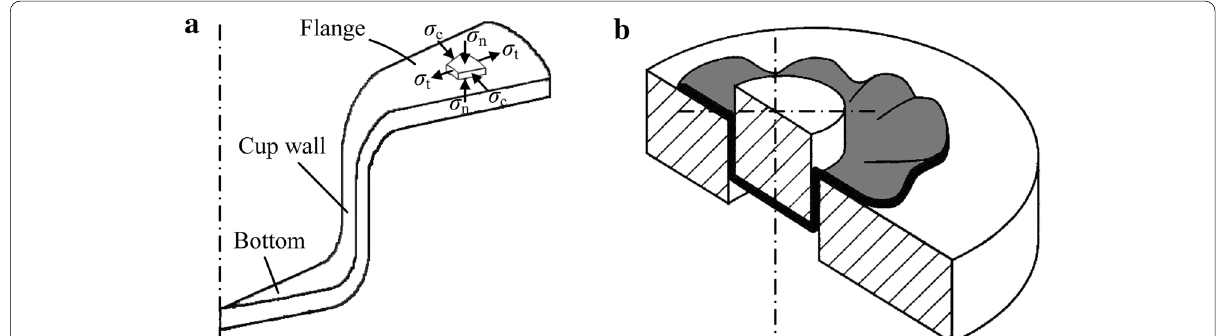
Figure 11 Schematic illustration of wrinkling generation in deep drawing: a stress conditions in flange, b wrinkling occurred in